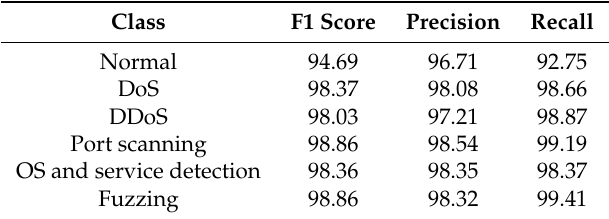
Table 6. Performance of RF using initially selected 10 features.